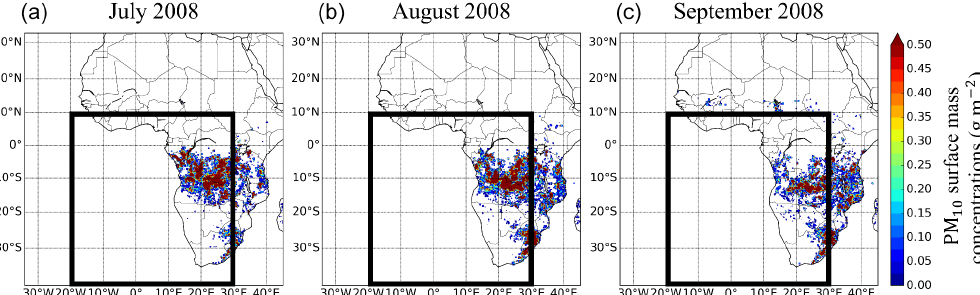
Figure 1. Monthly mass concentrations of PM 10 (in gm − 2 ) emitted at the surface by African biomass burning in July (a) , August (b) and September (c) 2008 from the APIFLAMEv1 biomass burning emission inventory (Turquety et al., 2014). The black frames (20 ◦ W–30 ◦ E, 39.4 ◦ S–10 ◦ N) represent the area of